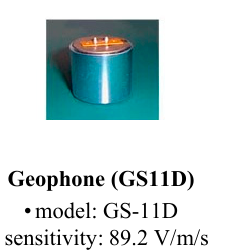
Figure 1. Sensors used for instrumentation.